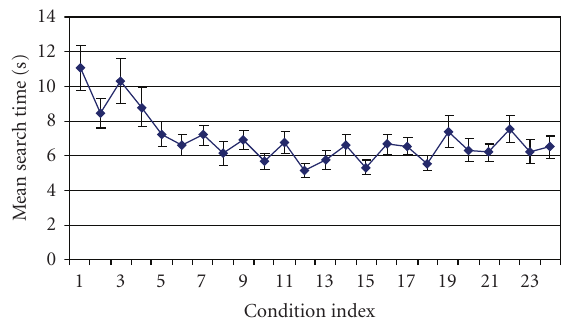
Figure 8: Task time over progressive trials averaged over all sensor types and visualization